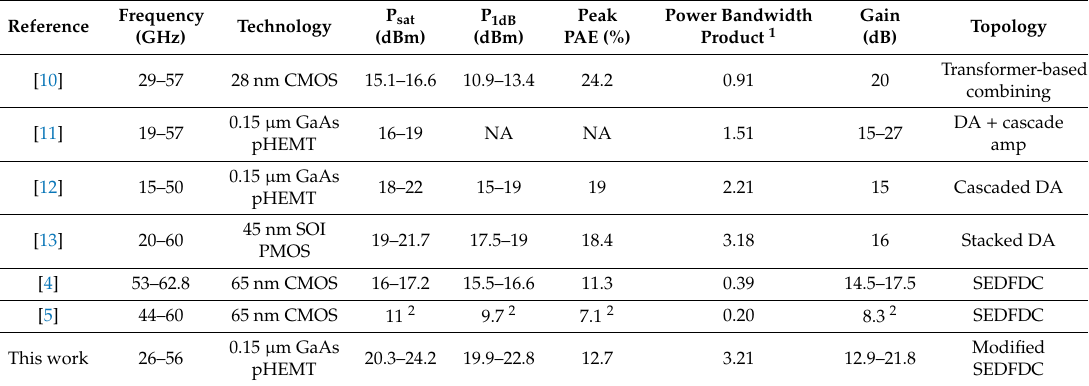
Table 2. Performance comparison of broadband millimeter-wave PA MMICs available in the entire Ka-band and Q-band / SEDFDC PA